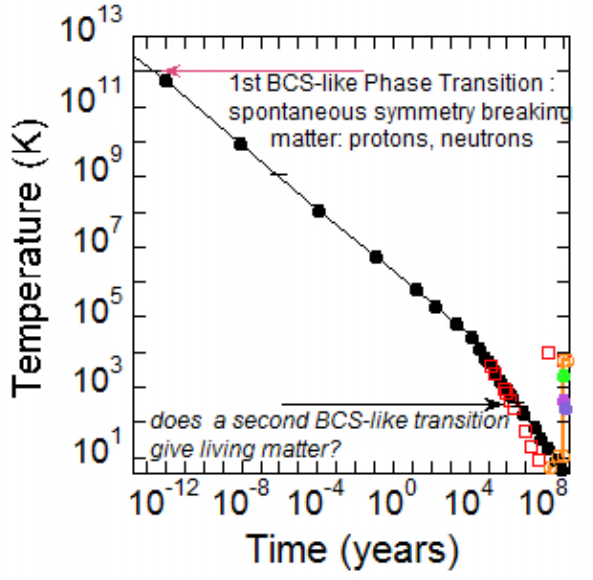
Figure 1. The temperature evolution of the Universe as a function of time in the early stage of the Universe after the Big Bang. The first BCS like phase transition occurring 10 -12 yr after the Big Bang was the origin of nuclear matter as we know today. In this work we propose that by decreasing temperature around the boiling point of water, it is possible that a second BCS like phase transition occurred that was the cause of the origin of living matter as we know